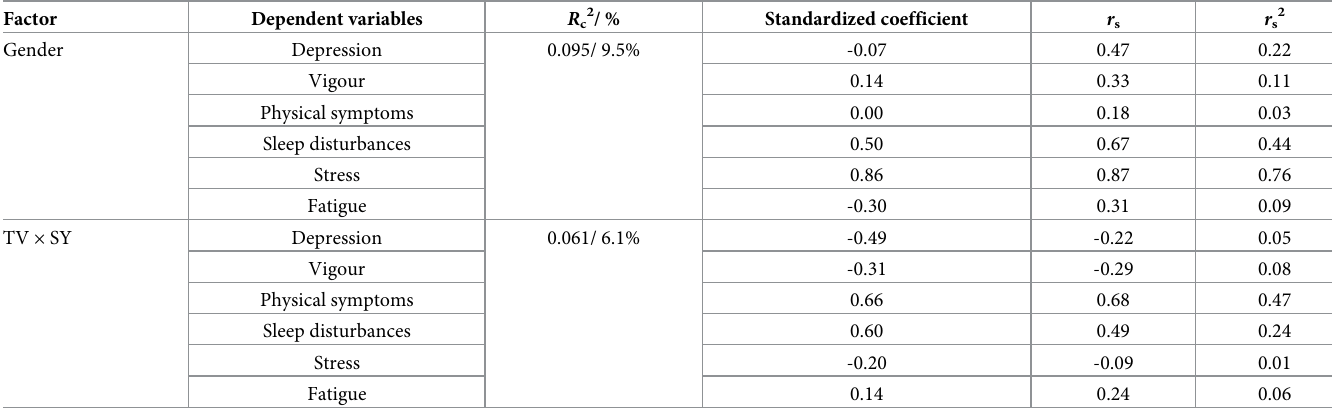
Table 5. The contribution of each outcome variable to the linear